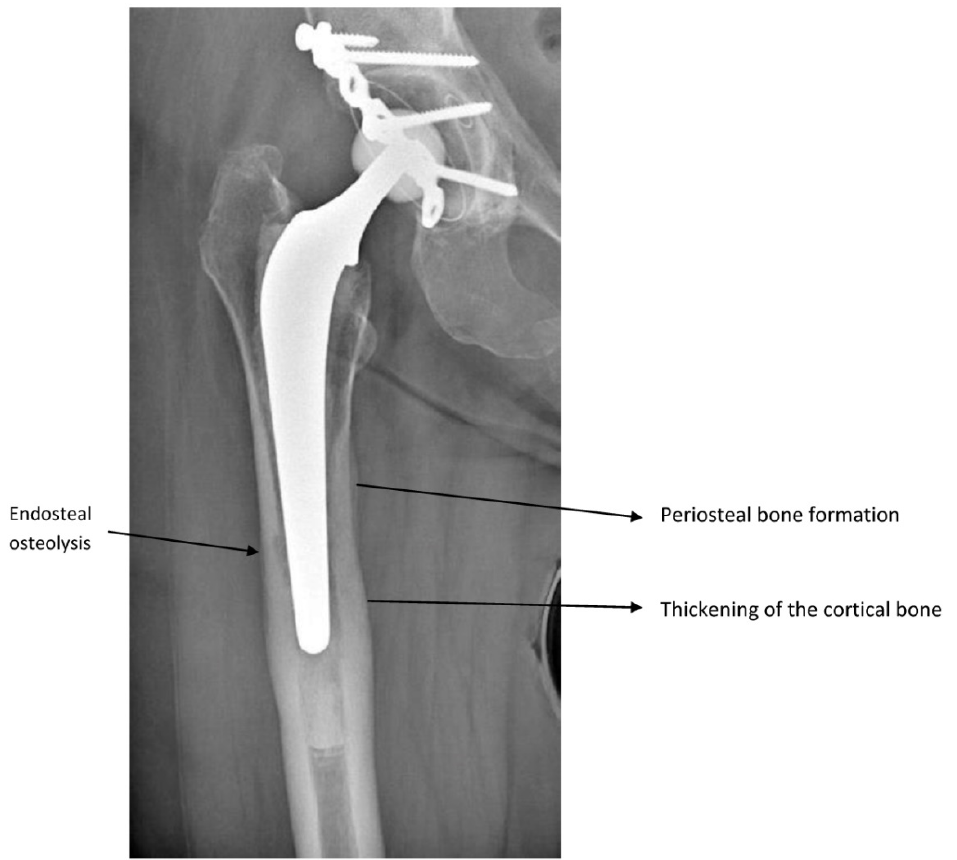
Figure 1. X-ray of Case 1’s right hip showing a cemented hip arthroplasty with signs of chronic femoral infection: endosteal osteolysis, periosteal bone formation and thickening of the cortical